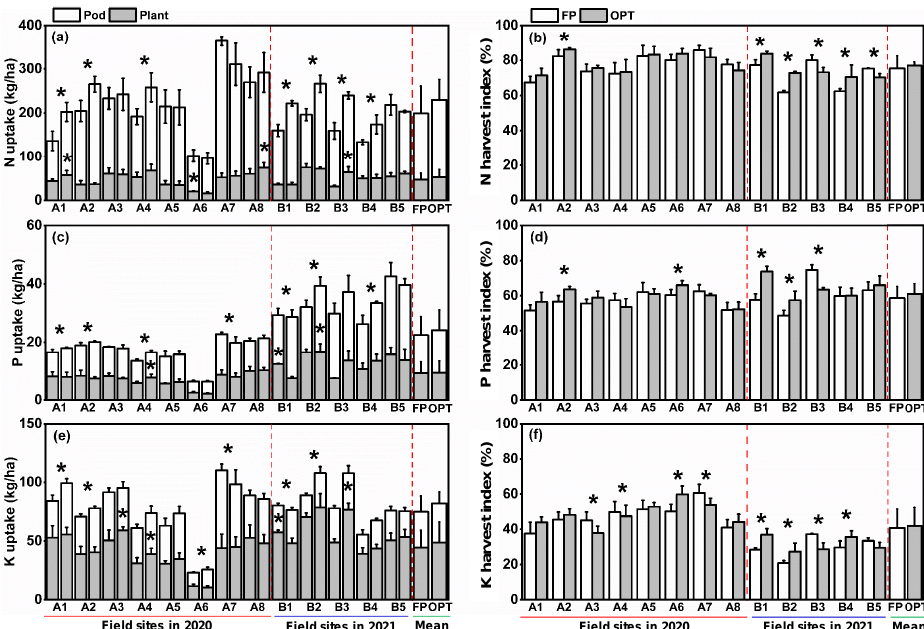
Figure 4. Uptake and nutrient harvest indexes of N ( a , b ), P ( c , d ), and K ( e , f ) in peanuts under different fertilization treatments. FP: farmers’ practice fertilization; OPT: optimized fertilization. A: experiment in 2021; B: experiment in 2022. Tentacle lines on the bars are standard deviation. Asterisks (*) on the bars indicate a significant difference at p < 0.05 between fertilization treatments for the same field site.